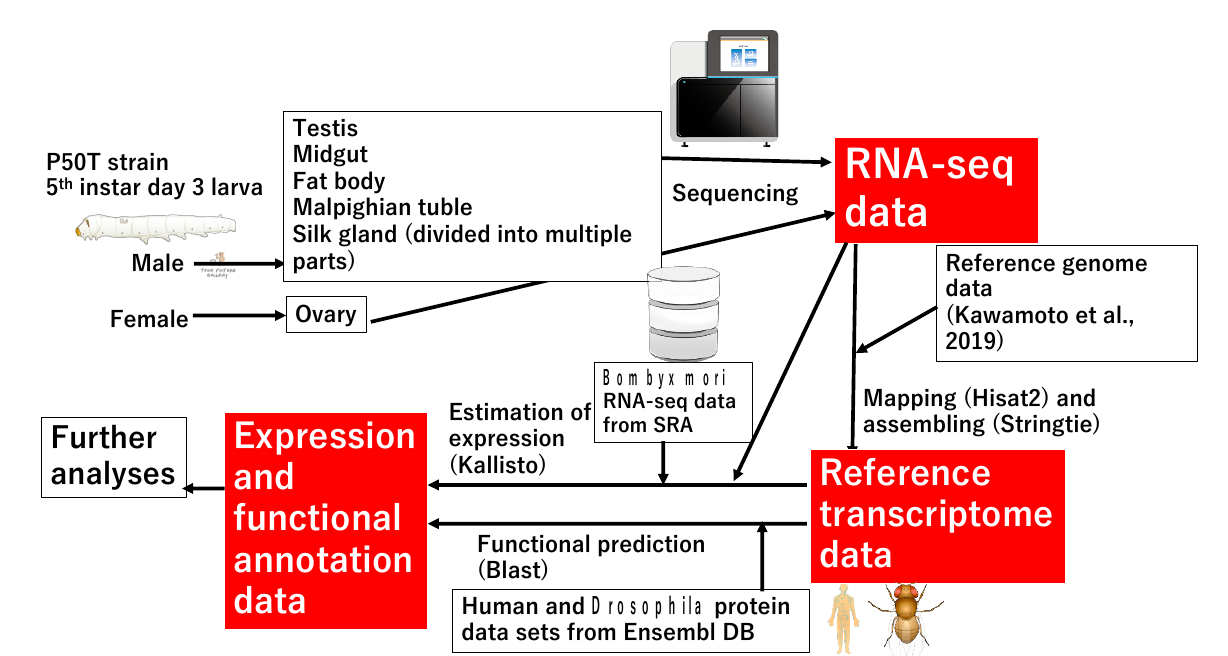
Figure 1. Workflow of the data analysis performed in the present study. To obtain reference transcriptome sequences, Fastq data of 10 tissues/subparts from fifth instar larvae were mapped to the new reference genome [15]. Kallisto software was used to estimate the expression abundance of each transcript in these tissues. Regarding RNA-seq data obtained from the public database (o751 strain; see Table 1). We performed a Blast search against human and Drosophila genome data to perform functional annotations of the reference transcriptome. The images in Figure 1 is from TogoTV (© 2016 DBCLS TogoTV).